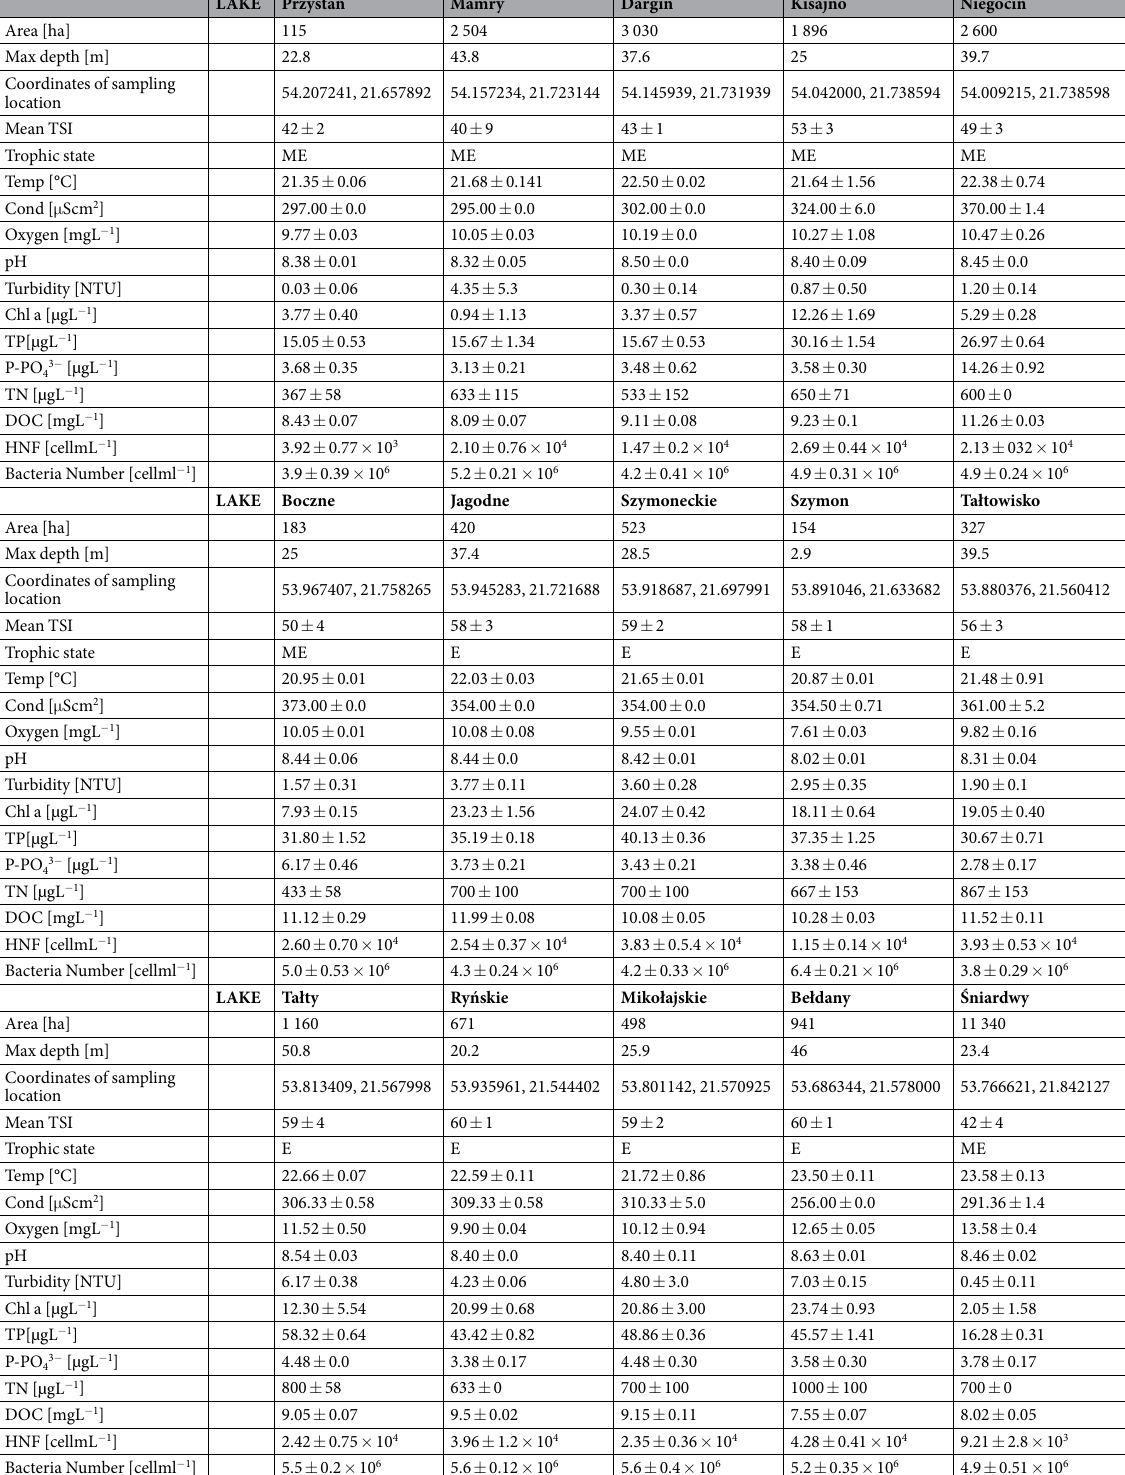
Table 1. The basic characteristics of the studied lakes. ± Are the standard deviation of mean values. Temp: temperature; Cond: special conductivity; Oxygen: Dissolved oxygen concentration; Turbidity: nephelometric turbidity; Chl a: chlorophyll a concentration; TP: total phosphorus; P-PO 43 − : dissolved orthophosphates; TN: total nitrogen; DOC: dissolved organic carbon; HNF: number of heterotrophic nanoflagellates; Bacterial number: number of DAPI-stained bacteria; Trophic state E: Lake belongs to the group of eutrophic lakes; Trophic state ME: Lake belongs to the group of meso-eutrophic lakes; Mean TSI: Mean Trophic State Index calculated on the basis of the concentration of chlorophyll a, total phosphorus and the visibility of the Secchi